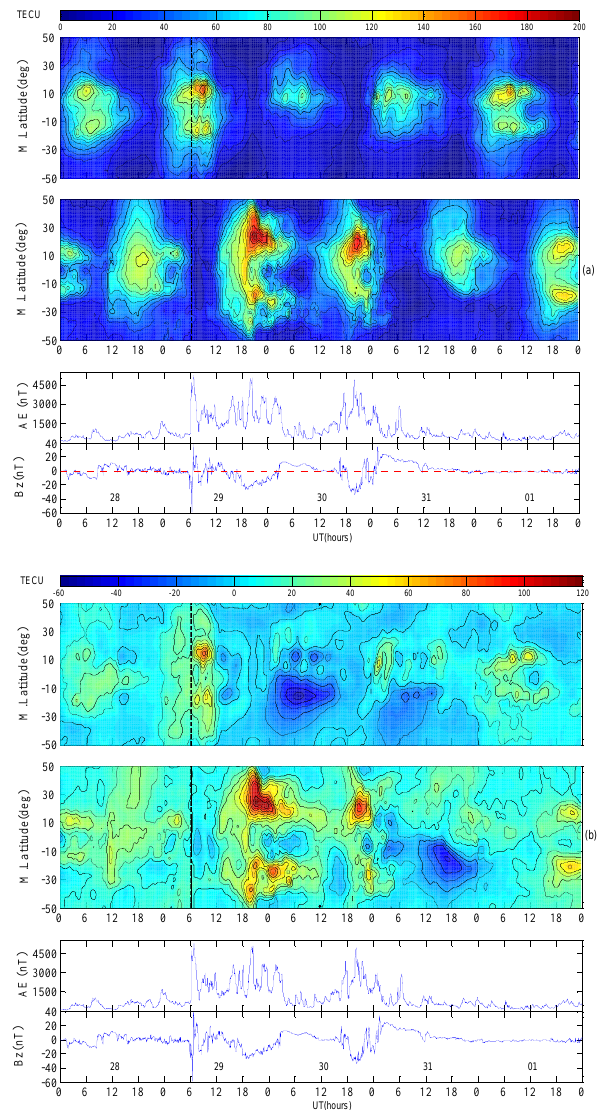
Fig. 3. ( a ) The TEC variation during the October storm vs universal time and geomagnetic latitude at two longitudes: 110 ◦ E (top panel) and 70 ◦ W (middle panel). The bottom panel shows the correspond- ing AE index and IMF B z . the vertical dashed line denotes the SSC. ( b ) Same as Fig. 3a, but for absolute TEC deviation.